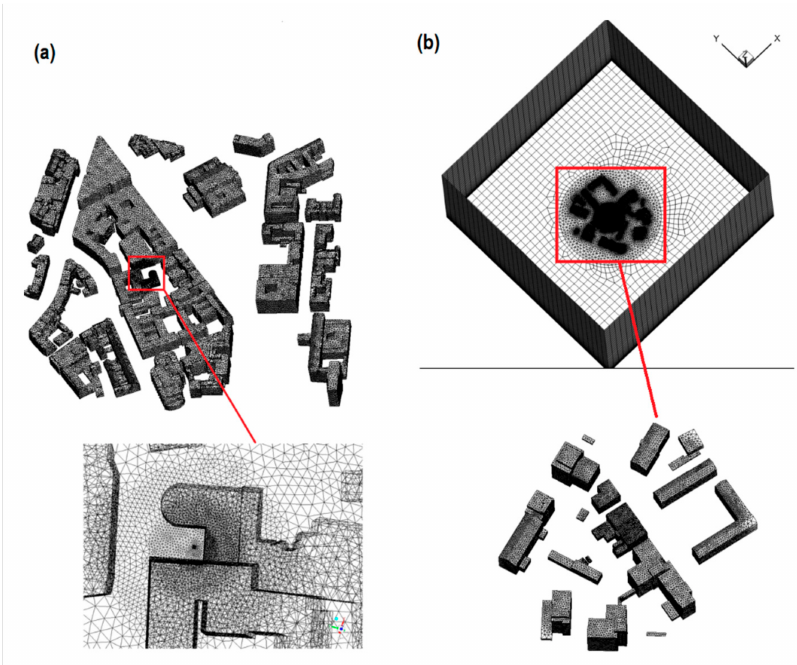
Figure 4. ( a ) Mesh used for Hanover city case 40 million cells, ( b ) mesh used for Frankfurt city case 10 million